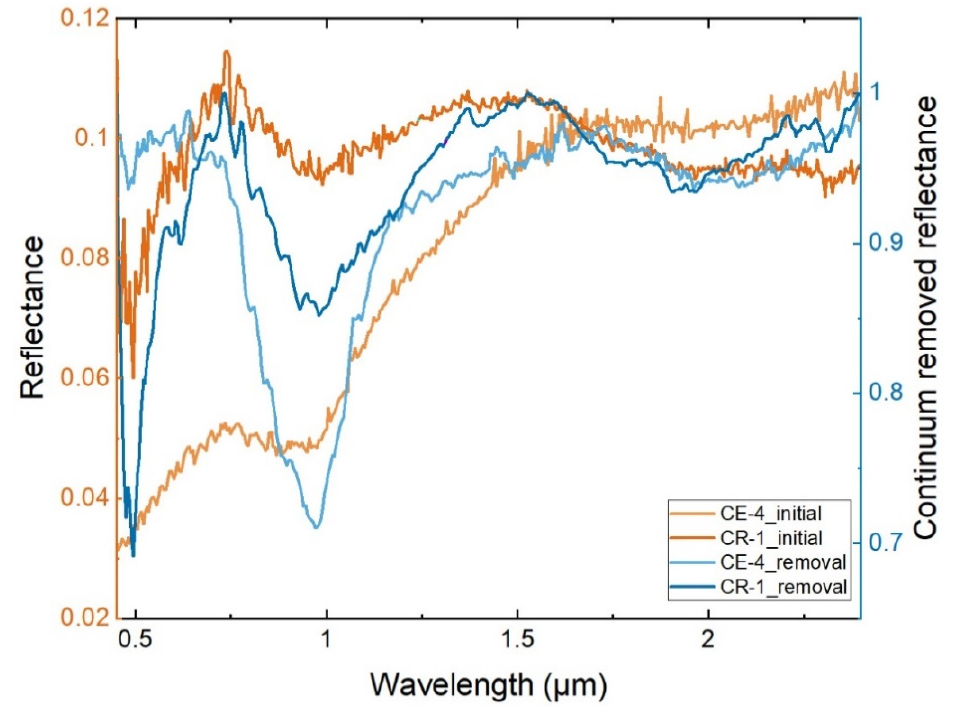
Figure 6. Spectra of the Chang’e-4 rock and CR-1 by VNIS. The light orange and blue lines are the initial and continuum removed spectra of the Chang’e-4 rock, respectively; the dark orange and blue lines are the initial and continuum removed spectra of CR-1, respectively.